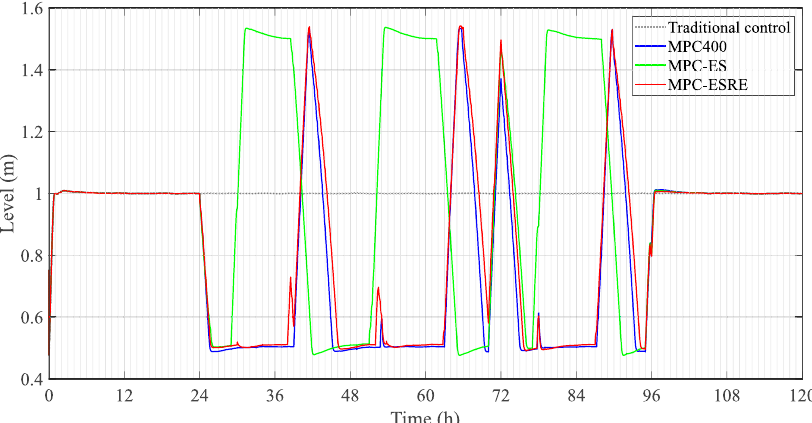
Figure 10. Low-pressure separator level of the multi-objective case study with the traditional control strategies and the different MPC scenarios.